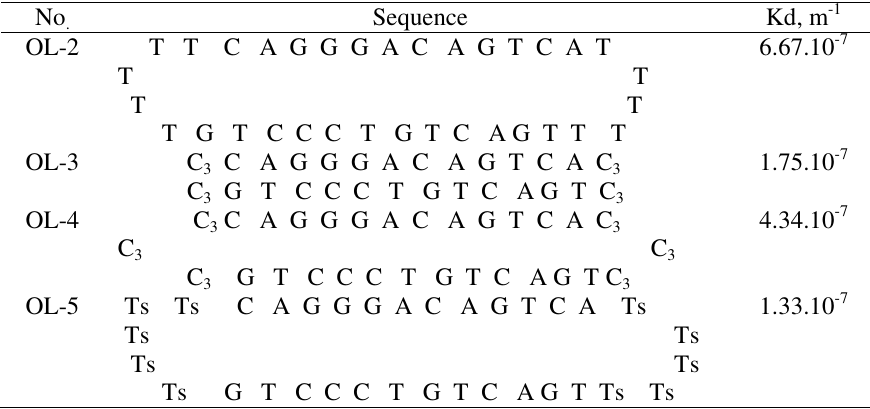
Table 1. Sequence of Dumbbell